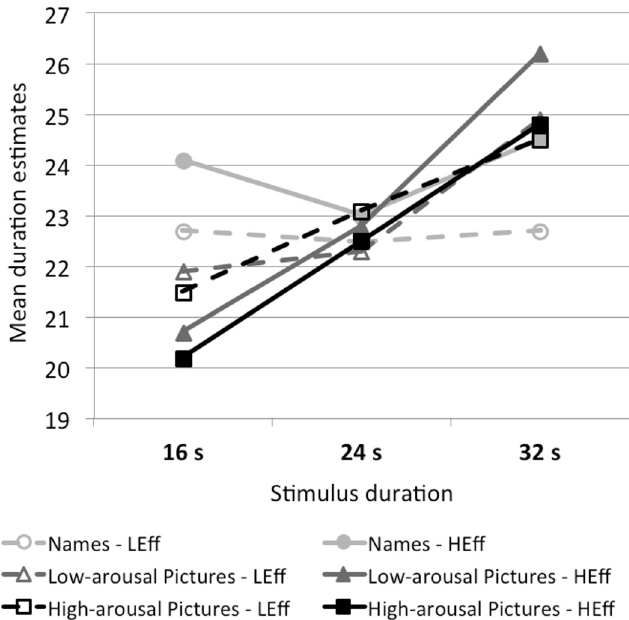
Fig 3. Sensitivity to duration. Sensitivity to stimulus duration in the different stimulus-type and physical- effort conditions. Stimuli were presented for 16 s, 24 s, or 32 s. Duration estimates are averaged per participant over the three levels of presentation frequency. LEff = low physical effort; HEff = high physical effort. The figure displays differences in the sensitivity to duration depending on the stimulus type and physical